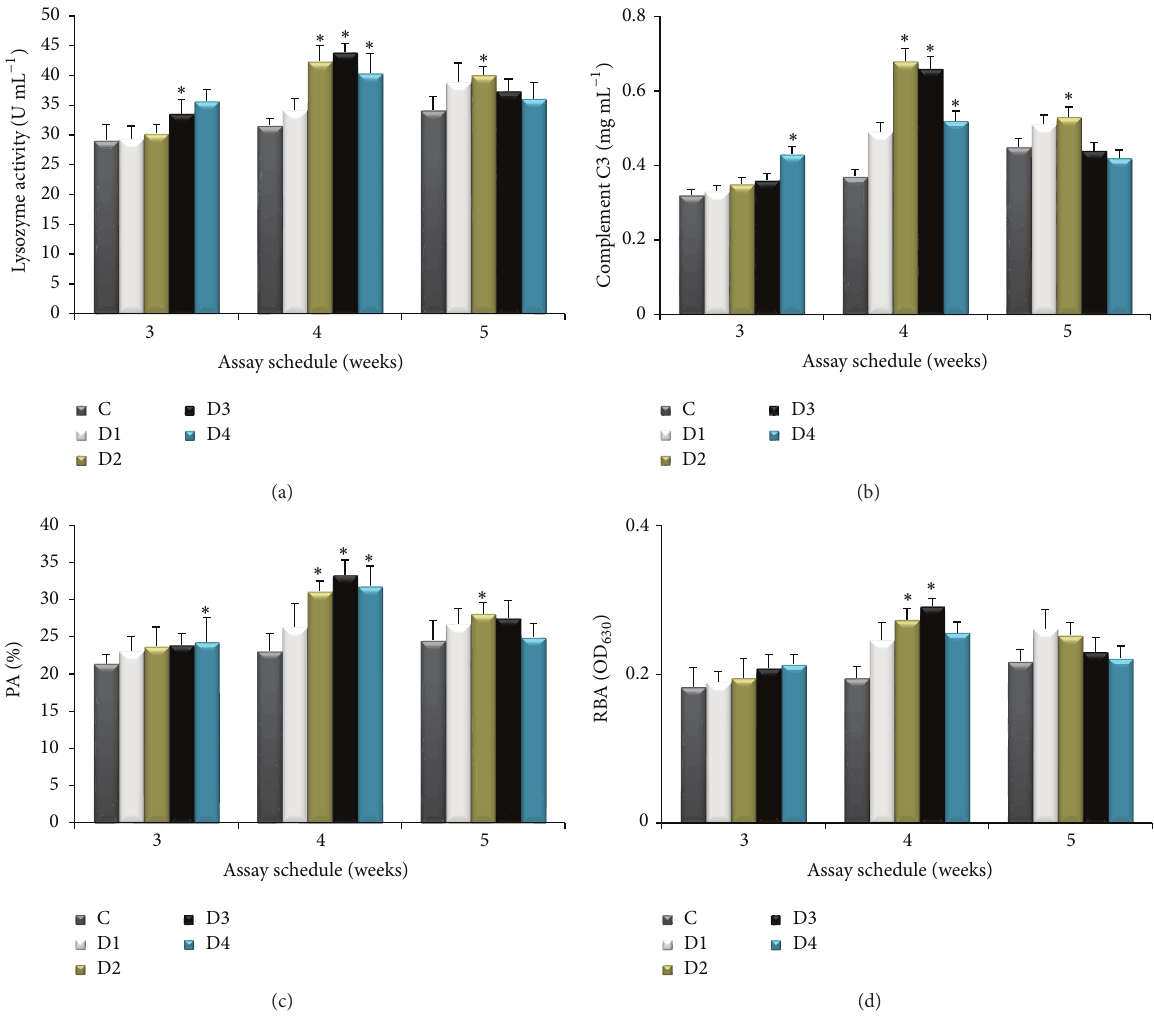
Figure 1: Serum lysozyme activity, complement C3, phagocytic activity (PA), and respiratory burst activity (RBA) of Labeo rohita ( 𝑛 = 15 ) at the end of weeks 3, 4, and 5 of feeding with a graded level of CBP. Bars represent the mean ± SEM and asterisks represent levels of significant differences compared to the control ( 𝑃 < 0.05 ). Note: C (basal diet); D1 (basal diet + 0.1% CBP); D2 (basal diet + 0.2% CBP); D3 (basal diet + 0.3% CBP); D4 (basal diet + 0.4%